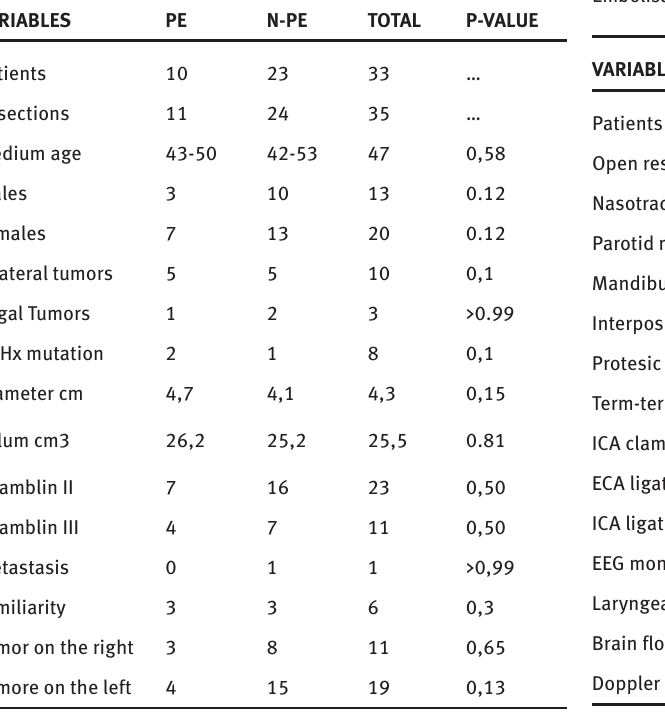
Table 2: Comparative analysis of surgical procedures in PE group (Preoperative Embolisation) and N-PE group (Non-Preoperative Embolisation: isolated traditional